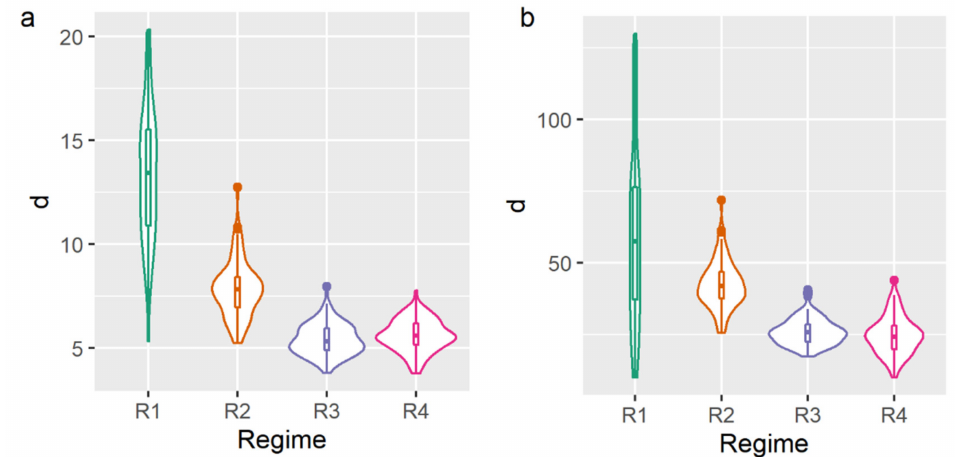
Figure 2. Crystal grain size distributions for beeswax-based ( a ) and beeswax hydrocarbons-based ( b ) oleogels prepared with different cooling